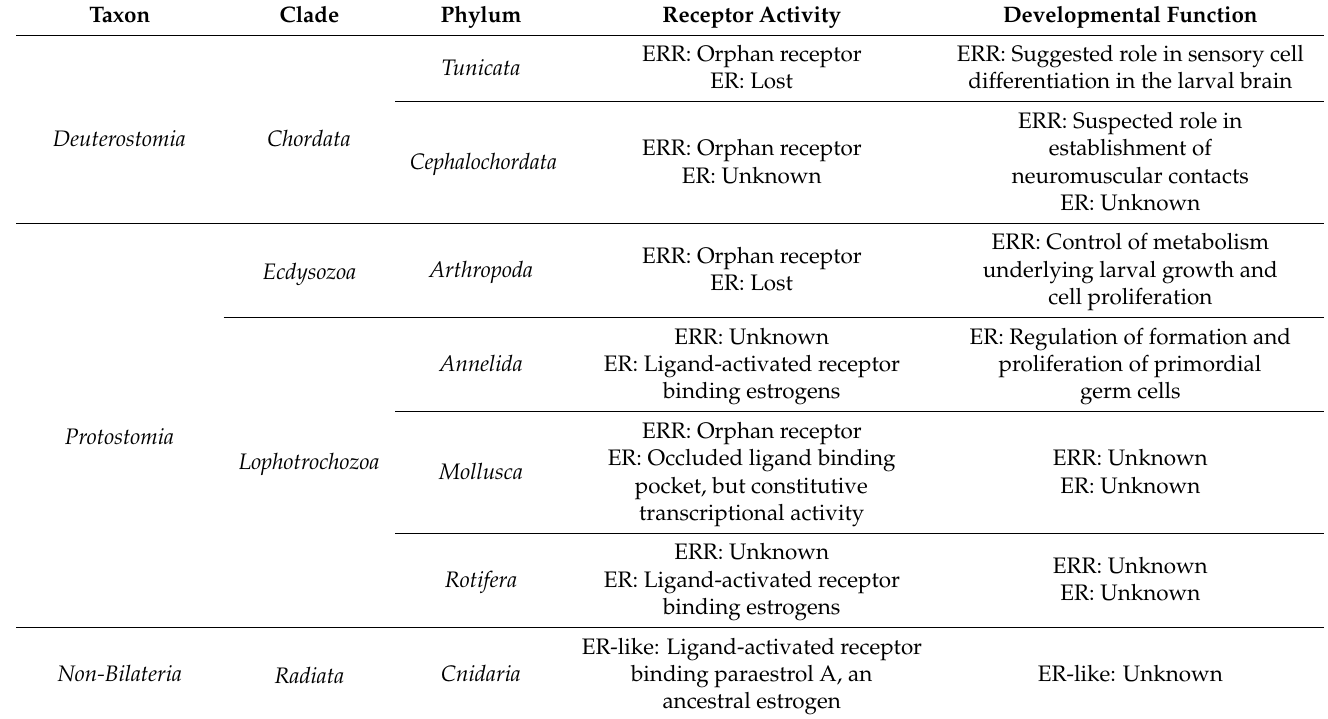
Table 4. Summary of estrogen receptor (ER) and estrogen-related receptor (ERR) functions in marine